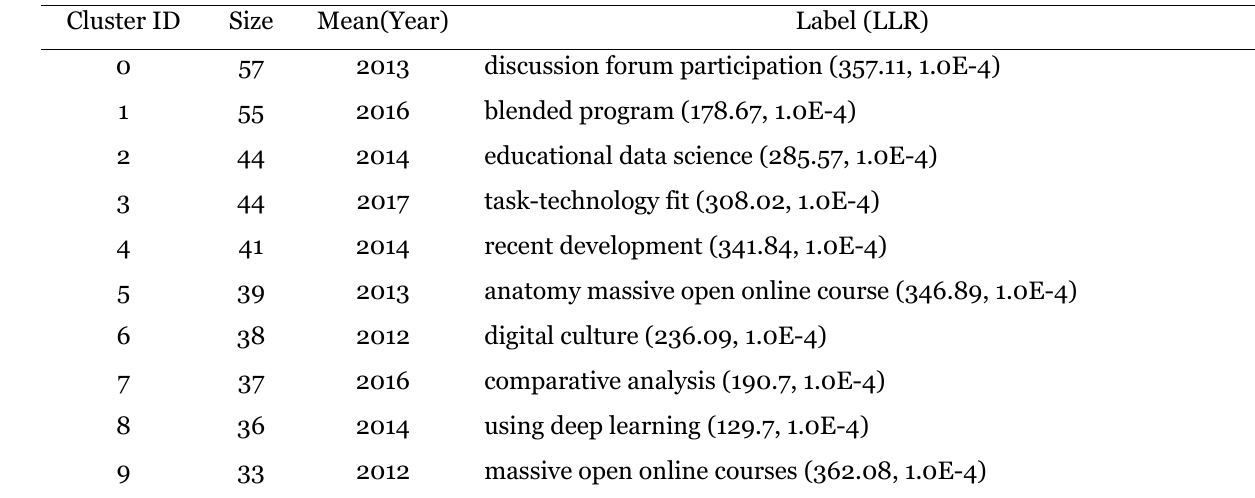
Top 10 Clusters of the Co-Citation Network with Automatically Retrieved Labels Cluster ID